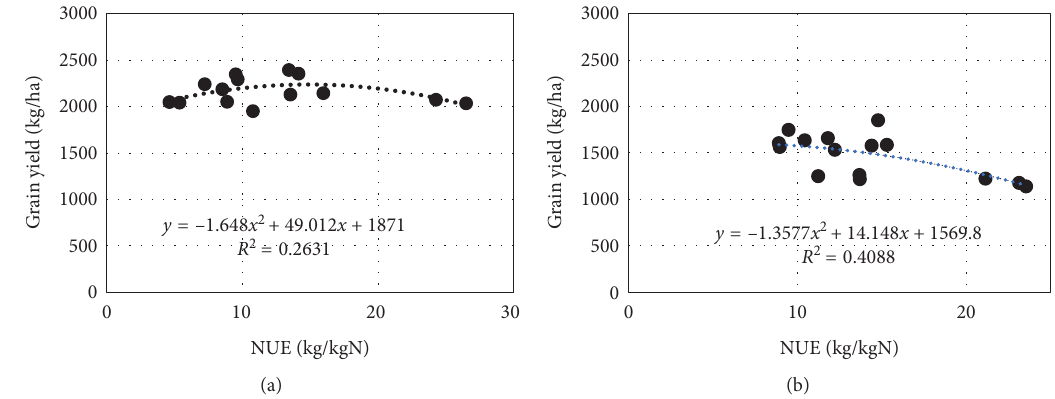
Figure 5: Quadratic relationship between NUE and grain yield (GY) of pearl millet in Minjibir and Gambawa sites. Each data point represents mean grain yield and NUE across N-fertilizer rates over two growing seasons (2014 and 2015). (a) Minjibir and (b)